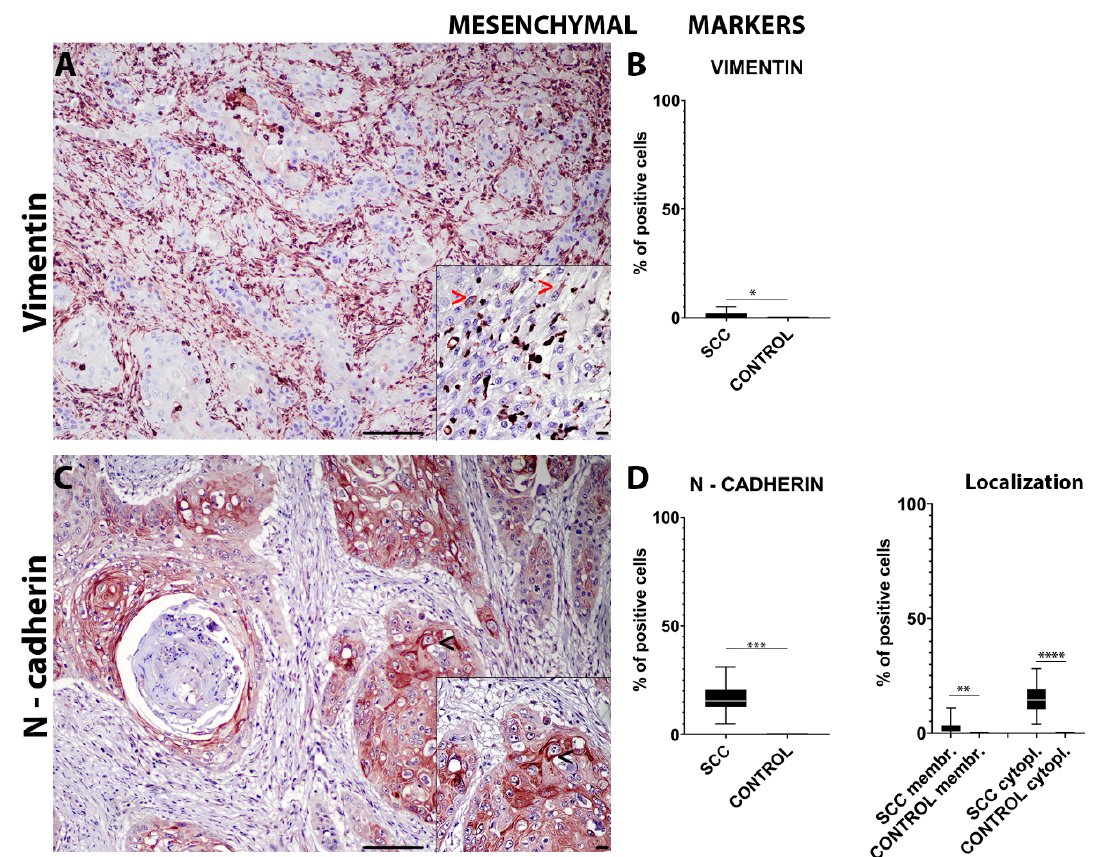
Figure 2. Immunohistochemistry for vimentin ( A ) shows an occasional expression in the cells on the epSCC invasive front (>—( A ) insert). Box-and-whisker plots show a higher number of cells immunolabeled for vimentin in the epSCC samples ( B ). Box-and-whisker plots showing a higher number of cells expressing cytoplasmic vimentin in the epSCC samples ( B ). Immunohistochemistry for N-cadherin ( C ) often shows a membranous expression in the cells on the epSCC invasive front (<—( C ) insert). Box-and-whisker plots show a higher number of cells immunolabeled for N-cadherin in the epSCC samples ( D ). Box-and-whisker plots showing a higher number of cells expressing membranous and cytoplasmic N-cadherin in the epSCC samples ( D ). Scale bar = 100 µm and scale bar-insert = 20 µm. All graphs represent box-and-whisker plots with * p < 0.05, ** p ≤ 0.01, *** p ≤ 0.001, and **** p ≤ 0.0001. SCC: squamous cell carcinoma group; SCC cytopl: squamous cell